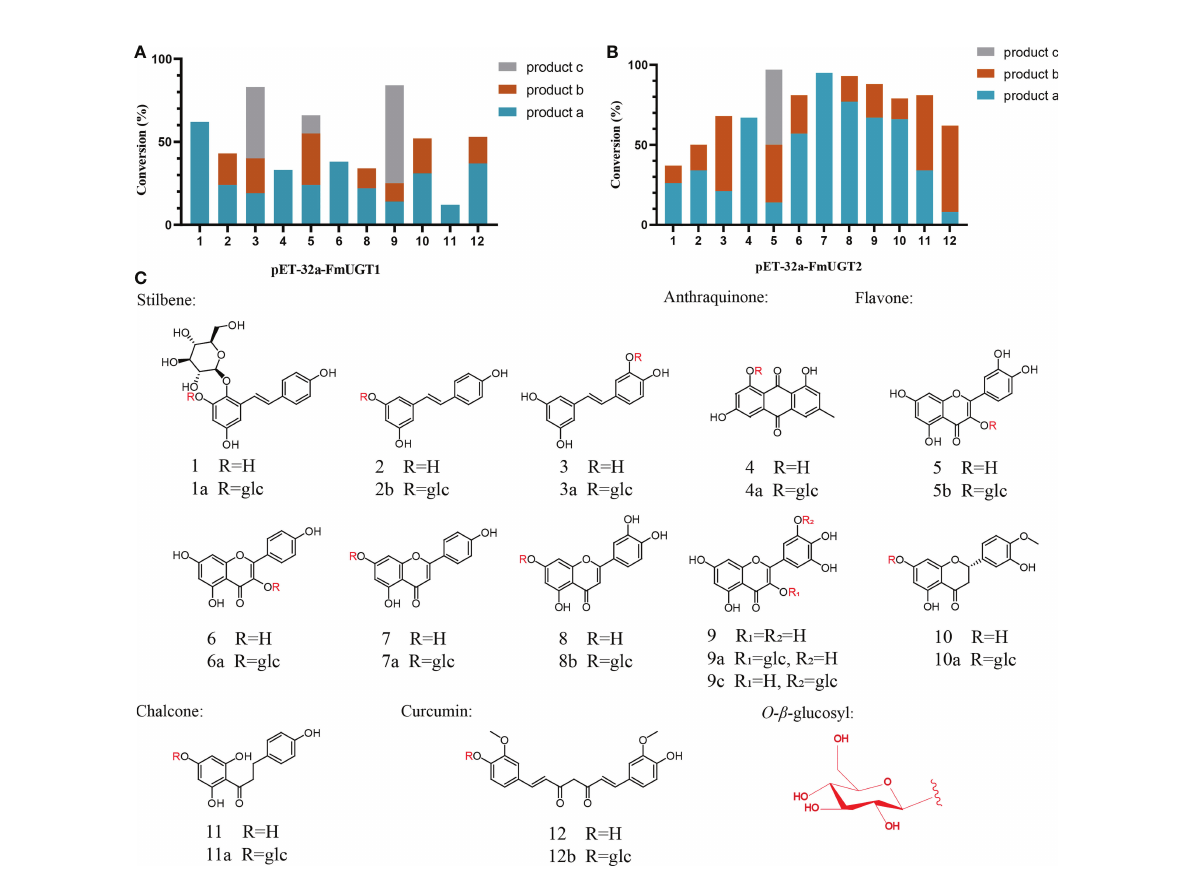
FIGURE 1 Substrate promiscuity of FmUGT1 and FmUGT2 . (A) Conversion rates (%) of FmUGT1 . (B) Conversion rates (%) of FmUGT2 . (C) Structures of substrates 1-12, (1) 2, 3, 5, 4 ’ -Tetrahydroxy stilbene-2- O- b - D -glucoside (THSG); (2) Resveratrol; (3) Piceatannol; (4) Emodin; (5) Quercetin; (6) Kaempferol; (7) Apigenin; (8) Luteolin; (9) Myricetin; (10) Hesperetin; (11) Phloretin; (12) Curcumin. (1a) 2, 3, 5, 4 ’ - tetrahydroxy-stilbene-2, 3-di - O- b - D -glucoside (polygonimitin C); (2a) Resveratrol 3- O- b - D -glucoside; (3a) Piceatannol 3 ’ - O- b - D -glucoside; (4a) Emodin 8- O- b - D